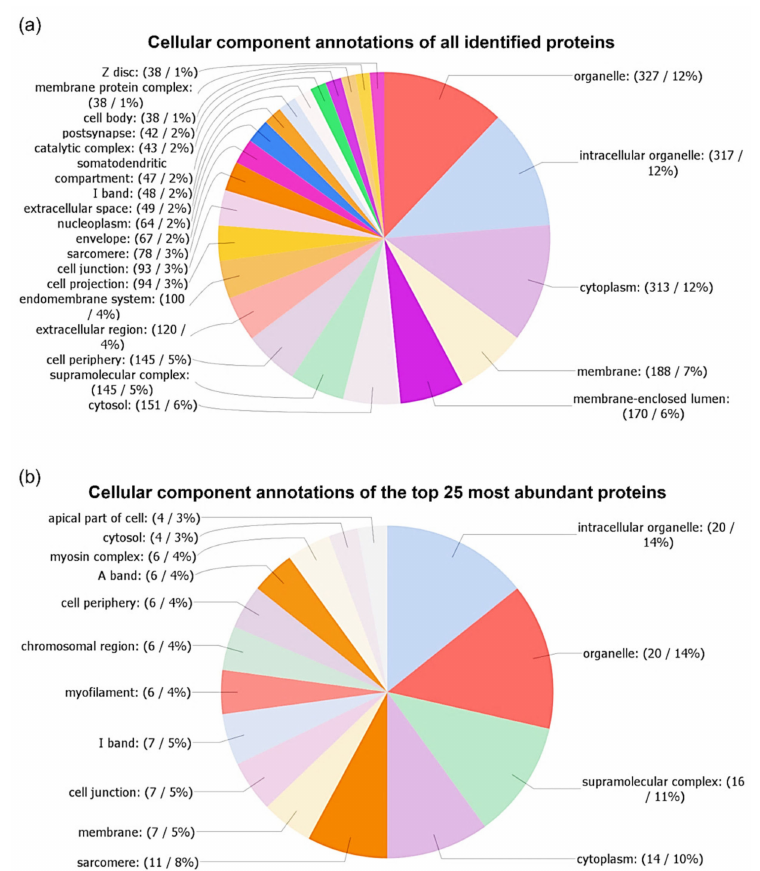
Figure 4. Gene ontology (GO) analysis of cellular components of all identified proteins ( a ), and the top 25 most abundant proteins ( b ). The number of annotations was limited for better readability in the following manner: a minimum of 38 matching sequences in GO analysis of all proteins, and a minimum of 4 matching sequences in the case of the top 25 most abundant proteins. Annotations were performed using OmicsBox